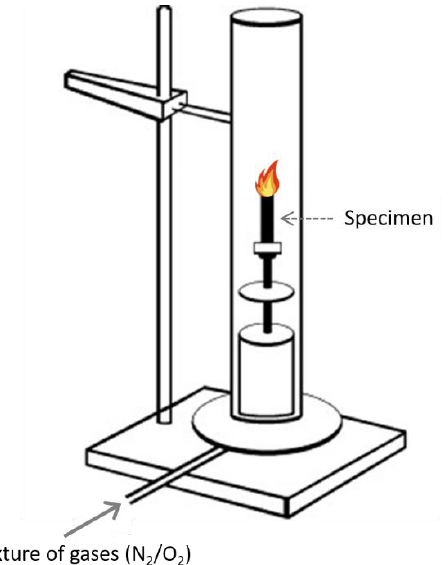
Figure 11. LOI test apparatus. Reprinted with permission from Ref. [137]. Copyright 2019, Else- vier.